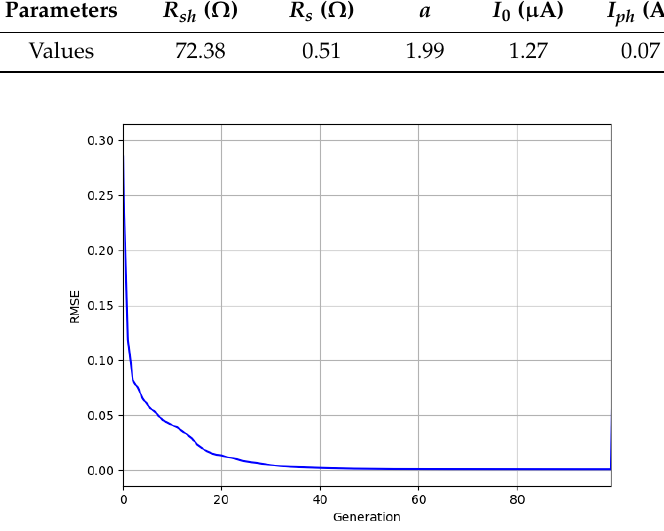
Figure 7. Evolution of average population fitness in the 100 iterations. Table 3. Extracted single diode parameter values for the FSTT cell.